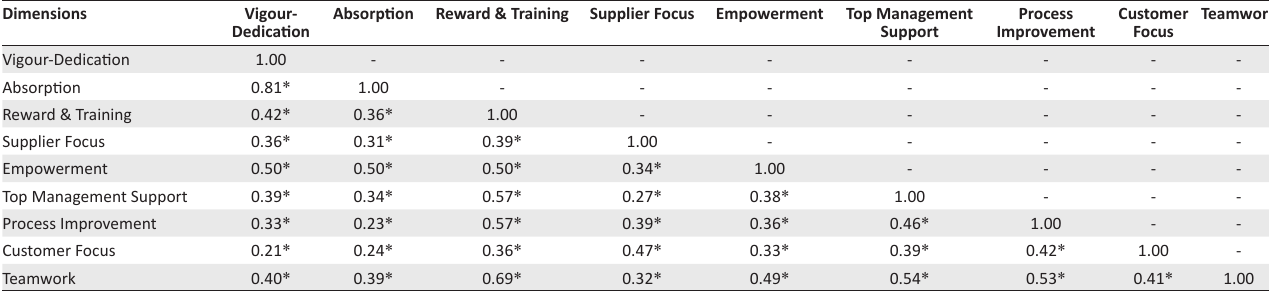
TABLE 6: Product-moment correlation coefficients between engagement and total quality management dimensions.